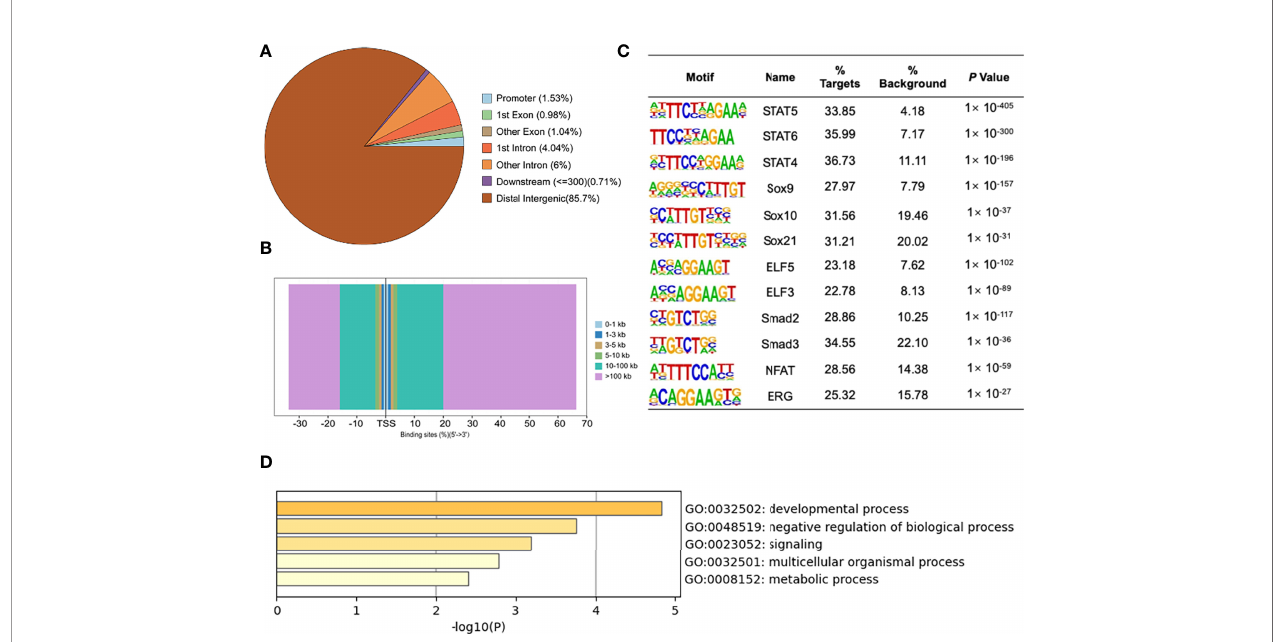
FIGURE 6 | ChIP-Seq pro fi les of MYBL2 in melanoma cells. (A) Pie chart of the percentage of MYBL2-binding sites across different human genomic regions. (B) Distribution of MYBL2 binding sites from ±100 kb to the transcriptional start site (TSS) across the human genome ( x -axis, number of peaks in the genome; y -axis, distance relative to the TSS from − 100 kb to +100 kb). (C) Logos of signi fi cantly enriched motifs detected. (D) GO enrichment analysis of MYBL2-binding target